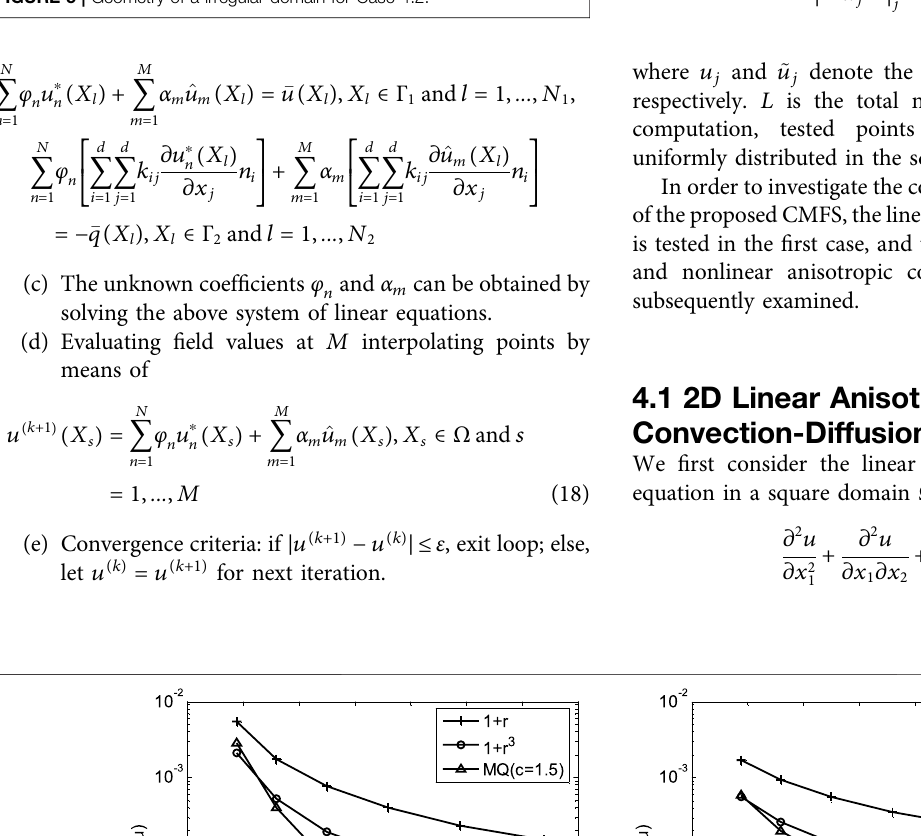
FIGURE 5 | Geometry of a irregular domain for Case 4.2.